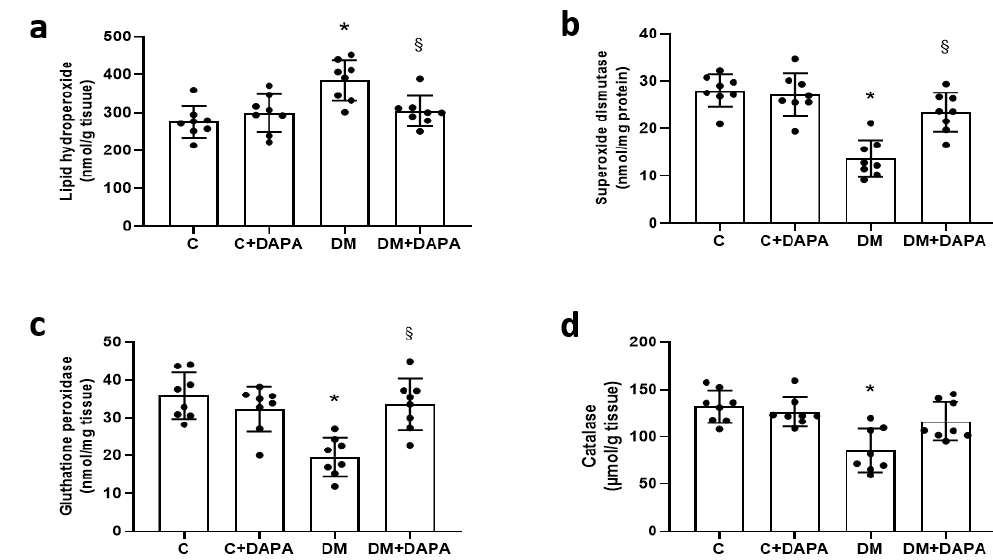
Figure 4. Left ventricular oxidative stress markers. Lipid hydroperoxide ( a ); superoxide dismutase activity ( b ); glutathione peroxidase activity ( c ); and catalase activity ( d ). Data are expressed as mean ± standard deviation. C: control; C + DAPA: control treated with dapagliflozin; DM: diabetes mellitus; DM + DAPA: DM treated with dapagliflozin; ANOVA for a 2 × 2 factorial design and Tukey; * p < 0.05 vs. C; § p < 0.05 vs. DM; sample size is 8 for all